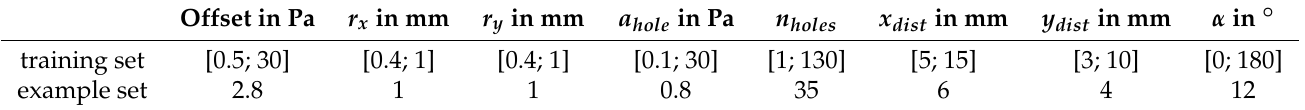
Table 1. Parameters used for sound field generation .